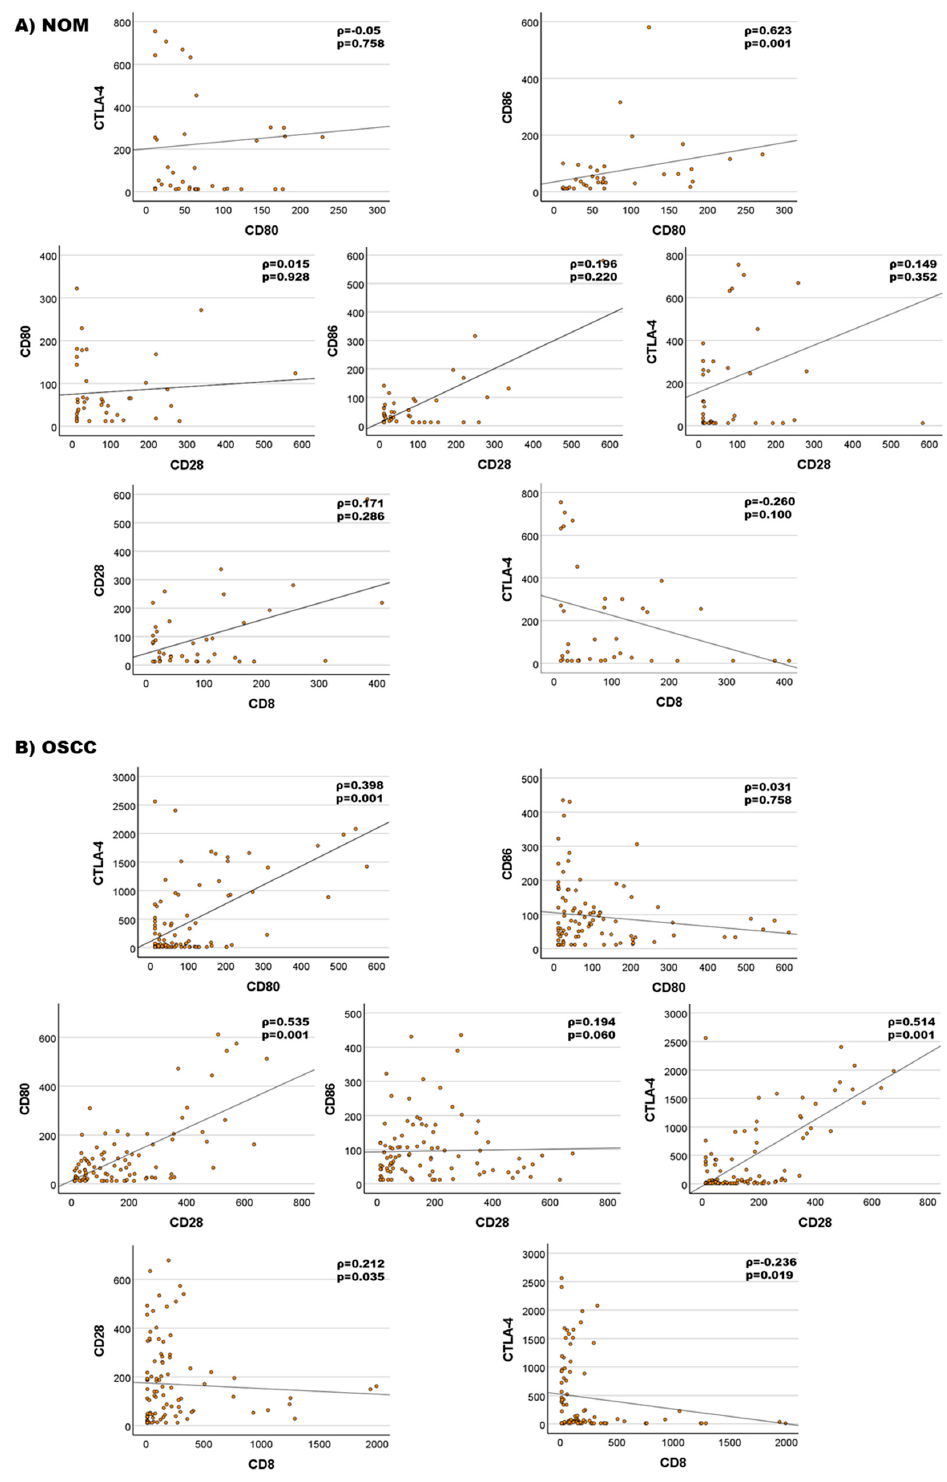
Figure 5. Correlation analysis of the CD28/CTLA-4–CD80/86 signaling pathway and of the immune modulators CD28 and CTLA-4 with the cytotoxic T-cell marker CD8. ( A ) In the NOM group ( n = 41), only CD80 and CD86 expression levels were moderately correlated. ( B ) OSCC ( n = 98): strong correlation between CD28 and CD80, e.g., CTLA-4, could be observed. CD80 and CTLA-4 expression levels were moderately correlated. No correlation between CD86 and CD80 was observed.